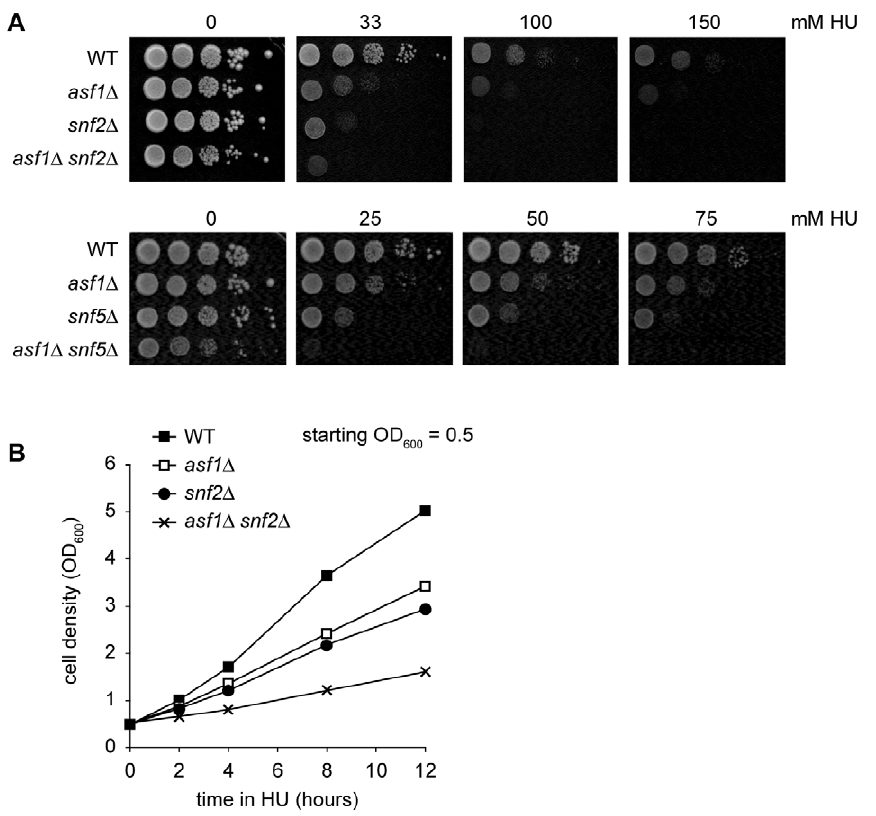
Figure 5. Asf1 and SWI/SNF contribute to survival under conditions of replication stress triggered by HU. A. asf1 D snf2 D (upper panel) and asf1 D snf5 D (lower panel) double mutants are sensitive to HU. Ten-fold serial dilutions of early log phase cells were photographed after 4 days of growth at 30 u C. B. asf1 D snf2 D double mutants are slow-growing in liquid medium containing 0.2 M HU.